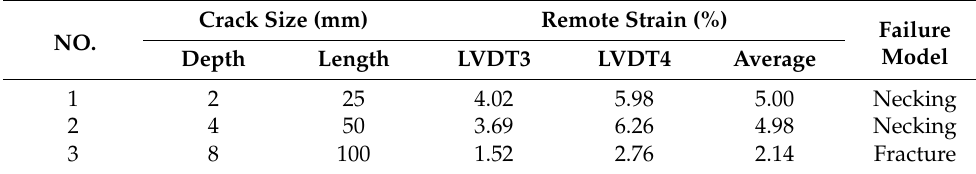
Table 3. The results of the CWP test.